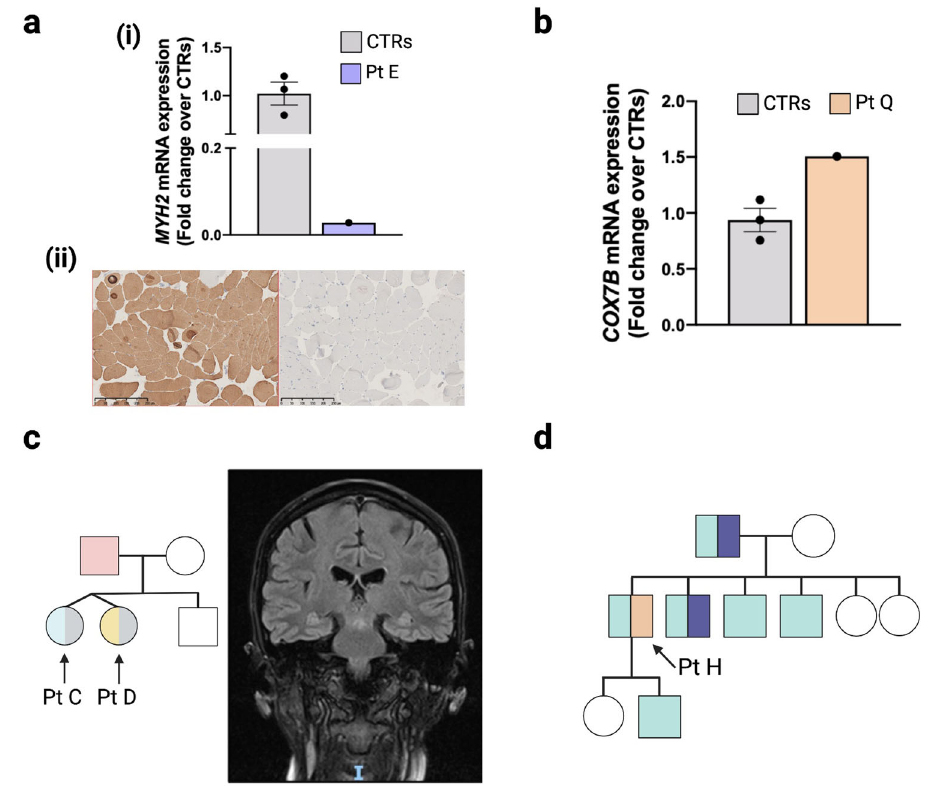
Fig. 2 | Factors contributing to additional diagnoses, part 1. a A novel non- coding MYH2 variant, c.4188-23T>A, with elevated splicing prediction scores was detectedintranswithaloss-of-functionvariant(c.30del).(i) MYH2 transcriptswere reduced (>99%) in the muscle tissue of Patient (Pt) E compared with controls (CTRs). This loss of MYH2 was supported by reverse phenotyping undertaken by pathology; MYH2 is expressed in2Afast fi bres.(ii)Leftimage — immunostaining for myosin heavy chains showed marked slow fi bre predominance. Right image — labelling for 2A fi bre speci fi c antibody ‘ 7.5.2B ’ was negative suggesting complete loss of 2A fi bres. Each staining was performed in two serial sections. b Increased